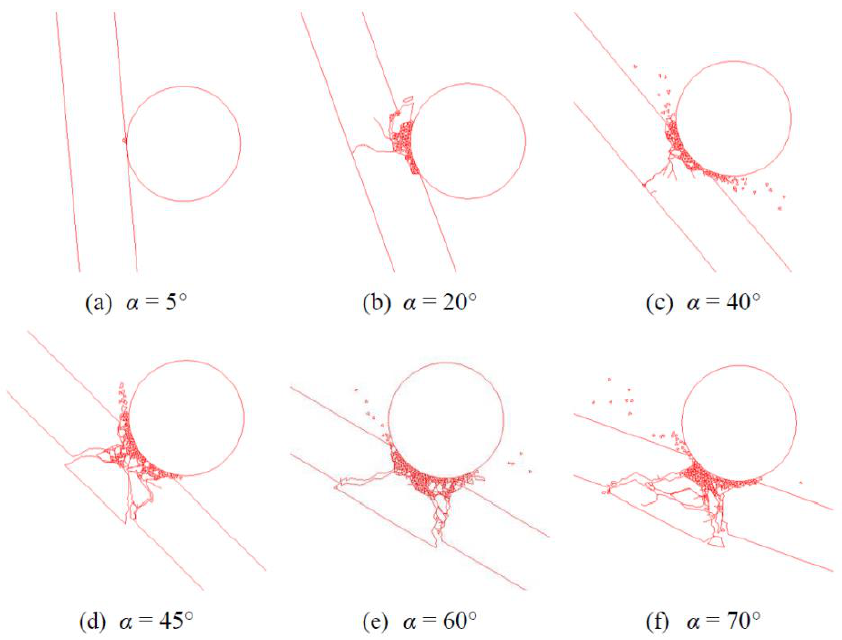
Figure 17. Fracture patterns of the glass beam with v = 5 m/s and different impact angles at t = 1 ms.